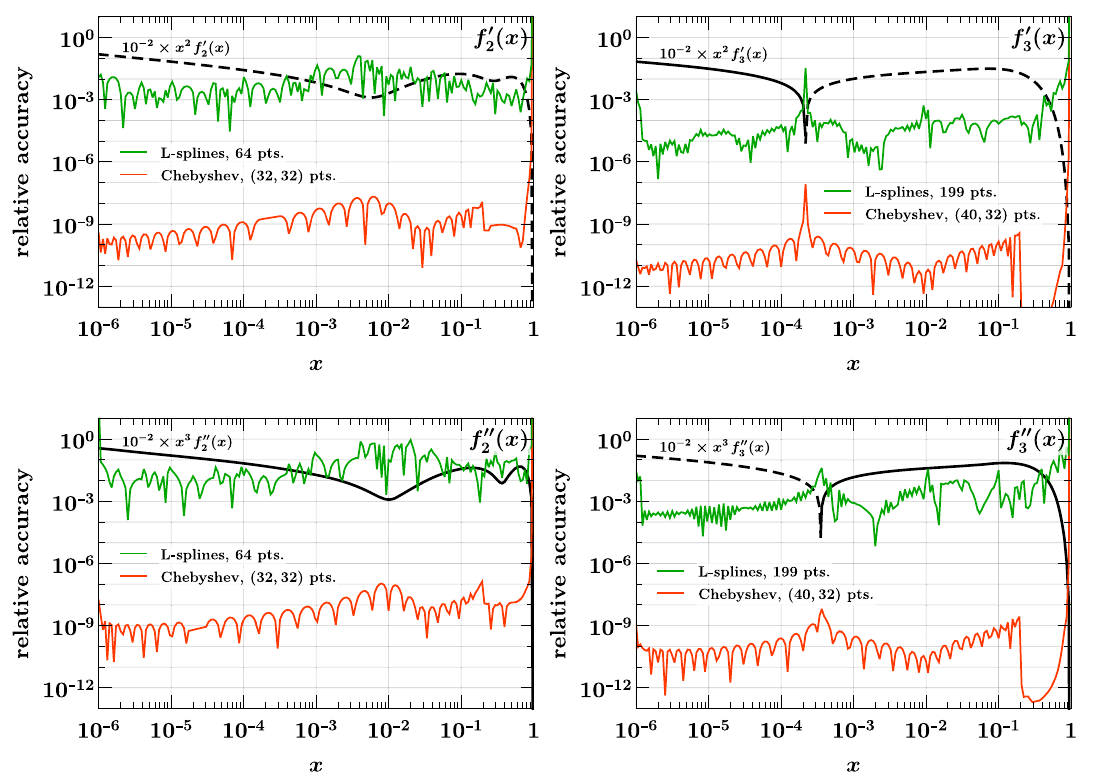
Fig. 5 Relative accuracy of the first derivative (top) and second derivative (bottom) for Chebyshev interpolation (red) and numerical differentiation of L-splines (green). The grids used on the left have lower n pts as in Fig. 1, and those on the right have higher n pts as in Fig.